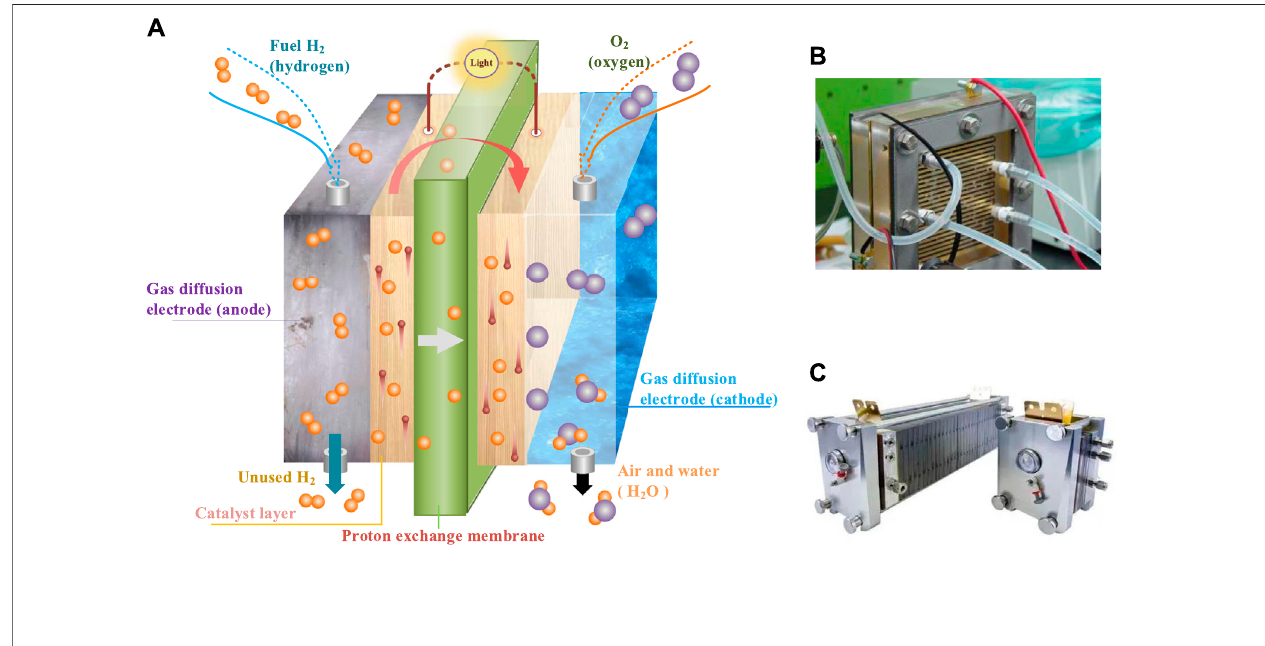
FIGURE 1 | Structure of PEMFC. (A) Electrochemical mechanism of PEMFC; (B) single PEMFC, and (C) PEMFC stack.